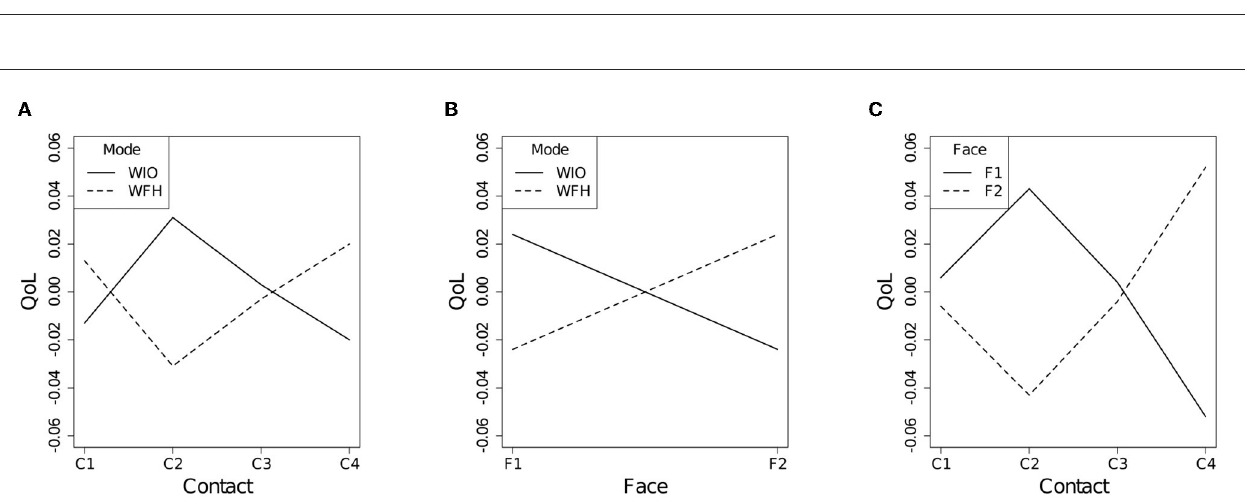
FIGURE2 Interaction plots (A) between the work mode and the social contact quantity, (B) between the work mode and the face-to-face contact ratio, and (C) between the social contact quantity and the face-to-face contact ratio.